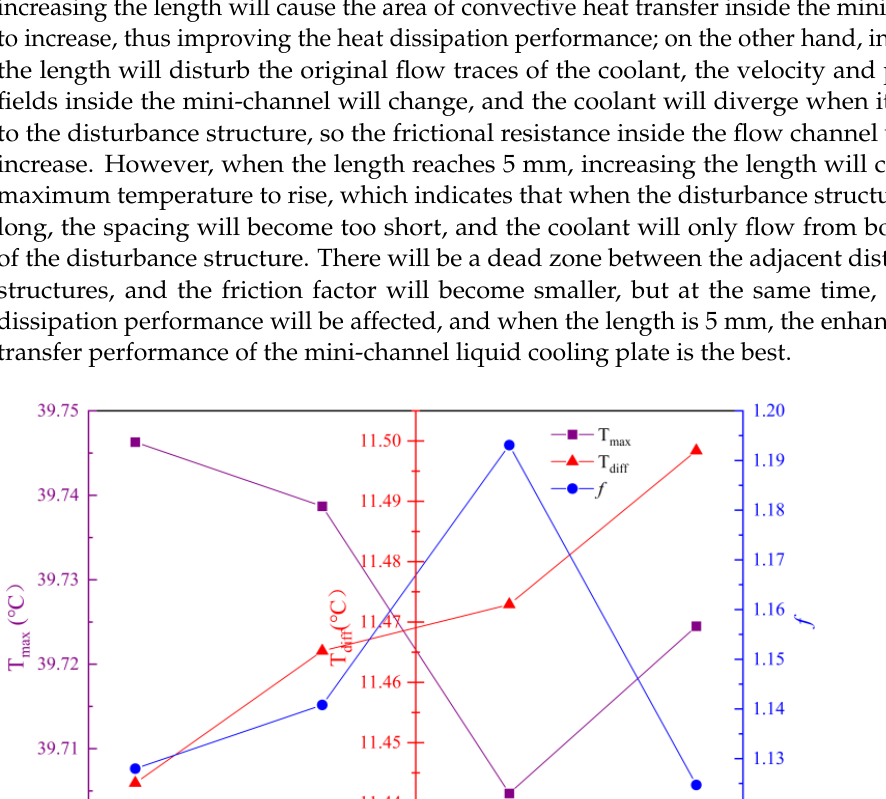
Figure 18. Influence of d 3 on evaluation indexes. With β as the horizontal coordinate and k as the vertical coordinate, the trend of the influence of the disturbance structure width on each evaluation index can be obtained, as shown in Figure 19. The friction factor gradually decreases as β increases, which indicates that the coolant in the cavity is subject to less frictional resistance when flowing out of the cavity, which is more conducive to the natural flow of the fluid. However, the maximum temperature and the maximum temperature difference increase slightly and then decrease significantly when β increases to 30°, which indicates that the heat dissipation is the worst at this value. At this value, the coolant flow velocity is low at the opening angle of the